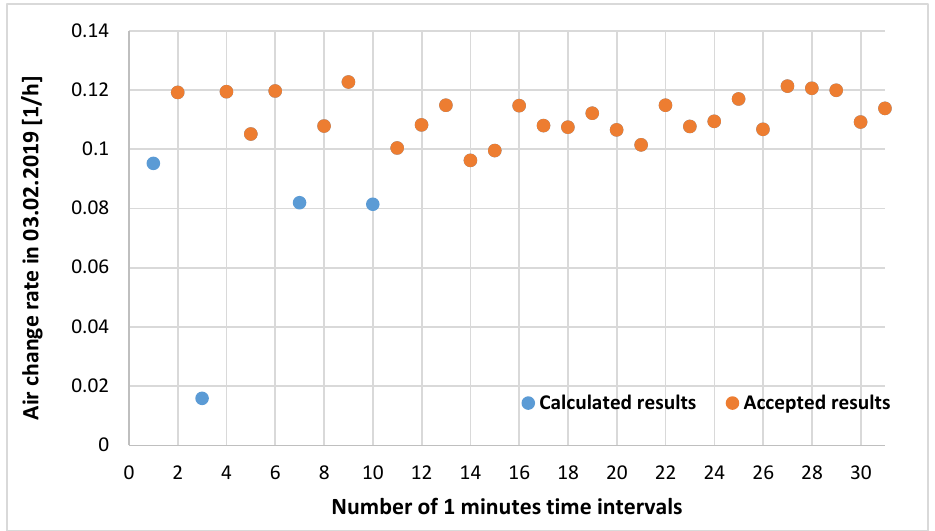
Figure 10. The screening of the calculated values of air change rate for 3 February 2019 (No 15). Calculated differences and margin of error of the air change rate established by cal- culations according to measurements of CO 2 are given in the Table 2.